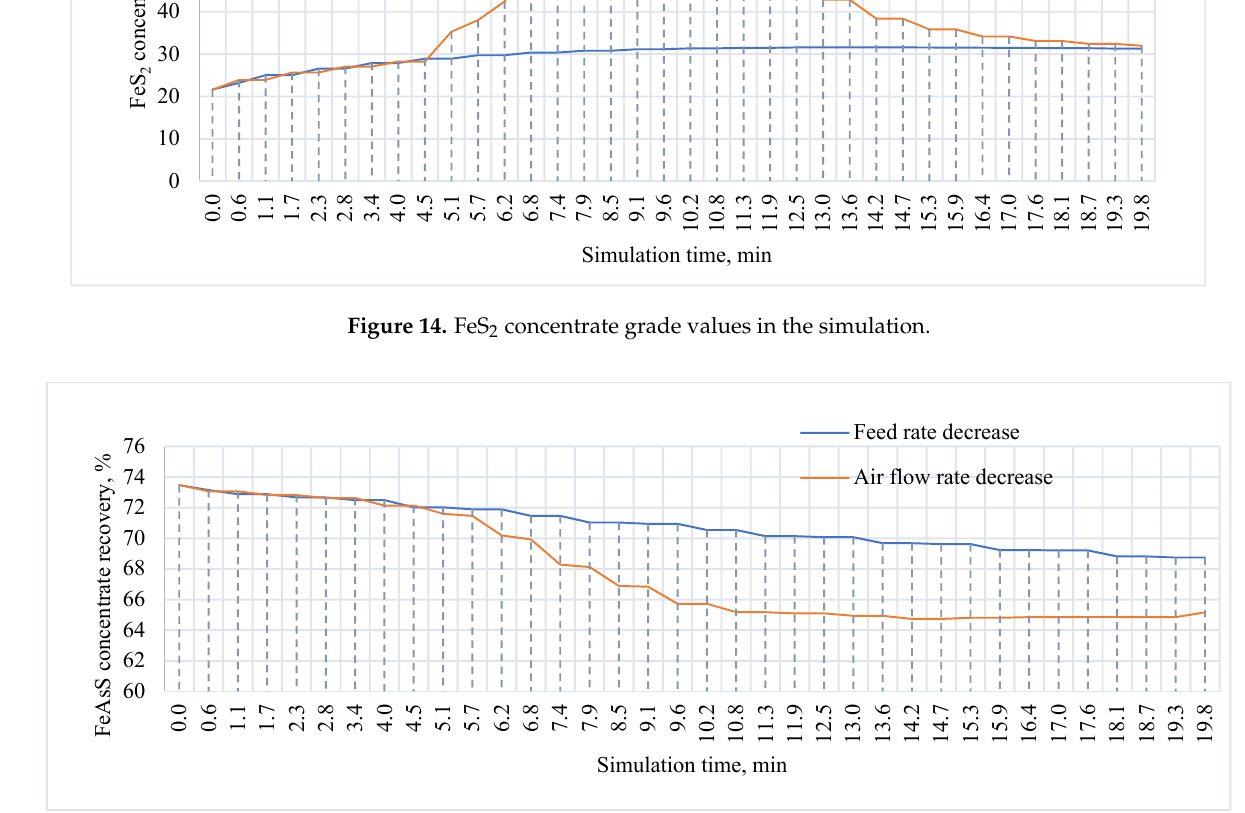
Figure 15. FeAsS concentrate recovery values in the simulation.